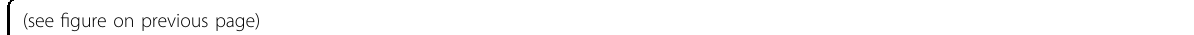
Fig. 5 KDM4A-PAF1 maintains appropriate expression of the MLLr-fusion oncogenic program in MLLr-AML. A Heatmap showing normalized ChIP-seq signal of H3K9me3 and H3K27me3 at TSS across all genes in KDM4A KD and NTC THP1 cells ordered by KDM4A enrichment. B Genomic snapshot demonstrates KDM4A occupancy at the PAF1 promoter region and enrichment of H3K9me3 and H3K27me3 signal throughout the PAF1 gene body and promoter upon KDM4A KD in comparison with NTC control in THP1 cells. Blue bars show the two individual probes used for ChIP- QPCR in C and D . C – D H3K9me3 and H3K27me3 ChIP signal/input (fold change of NTC) in the indicated human MLLr-AML cell lines ( C ) and indicated primary AML samples including PX21 (MLL-AF6) and PX30 (MLL-FA10) ( D ) as determined by ChIP-QPCR following depletion of KDM4A ; * p < 0.001. E Venn diagrams showing the overlap between directly bound downregulated and upregulated targets of KDM4A and the PAF1c 24 in THP1 cells following knockdown of KDM4A and PAF1 as determined by ChIPseq; p by hypergeometric test. F Motif signi fi cance and KDM4A log 2 enrichment at KDM4A or PAF1 regulated promoters (FDR ≤ 0.01, DE ≤ − 0.5, or DE ≥ 0.5). Color represents motif signi fi cance within KDM4A and PAF1 regulated promoters. Size denotes the average log 2 enrichment of KDM4A within each group of promoters that possess the respective transcription factor (TF) binding motif. Top fi ve motifs detected in KDM4A or PAF1 regulated promoters sorted by statistical signi fi cance ( E -value). G GSEA results showing signi fi cant overlap of KDM4A KD transcriptional consequences with downregulation of MLL-AF9 and HOXA9 targets and upregulation of a mature hematopoiesis program in THP1 cells, * q <